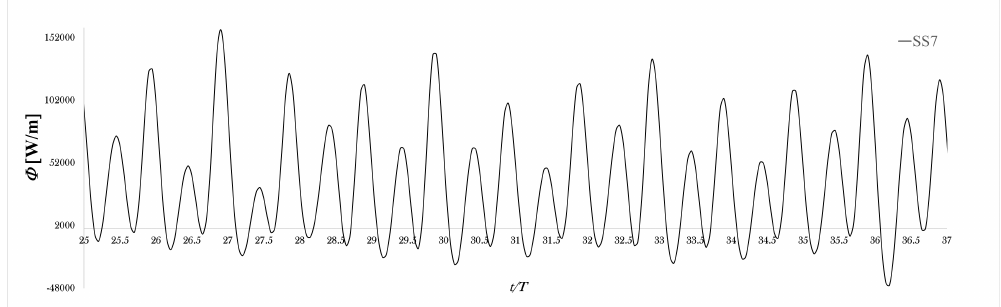
Figure 12. The instantaneous energy flux in the middle ( BB (cid:48) ) of the numerical flume, during a time period starting from t = 25 T ( H = 2.5 m, T = 8 s).